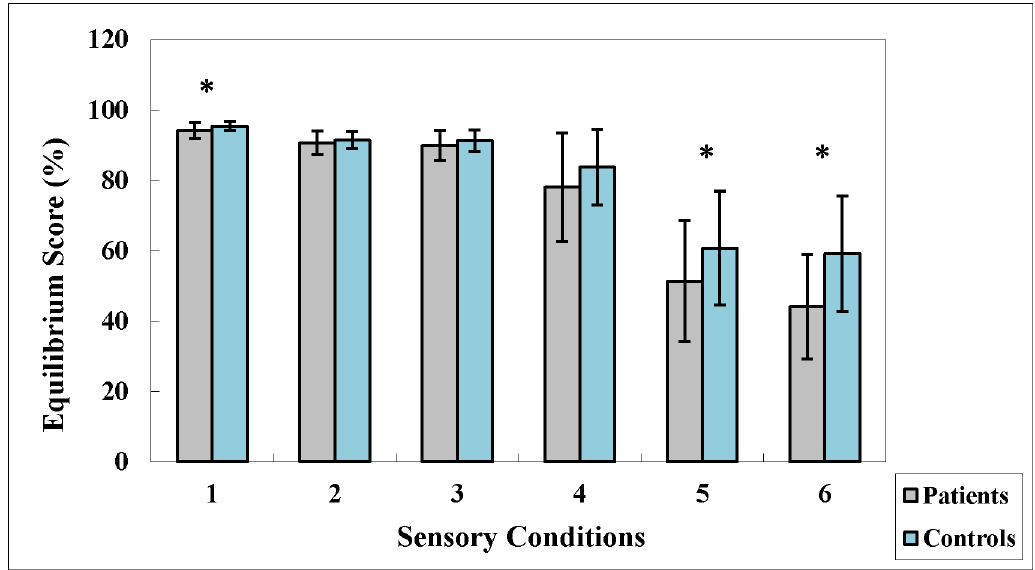
Fig 4. Mean Equilibrium scores for each sensory